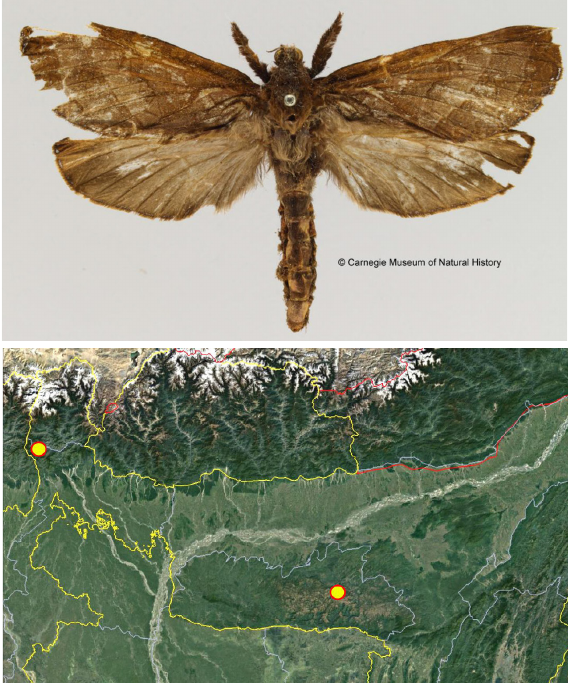
Image 2. Examples of Himalayan Thitarodes species: (a) Male of Thitarodes eberti Viette, 1968 from Nepal (Canadian National Collection). Photo by Jayne Hyland; (b) Male of Thitarodes caligophilus Maczey, 2010 from Bhutan. Photo by Norbert Maczey.